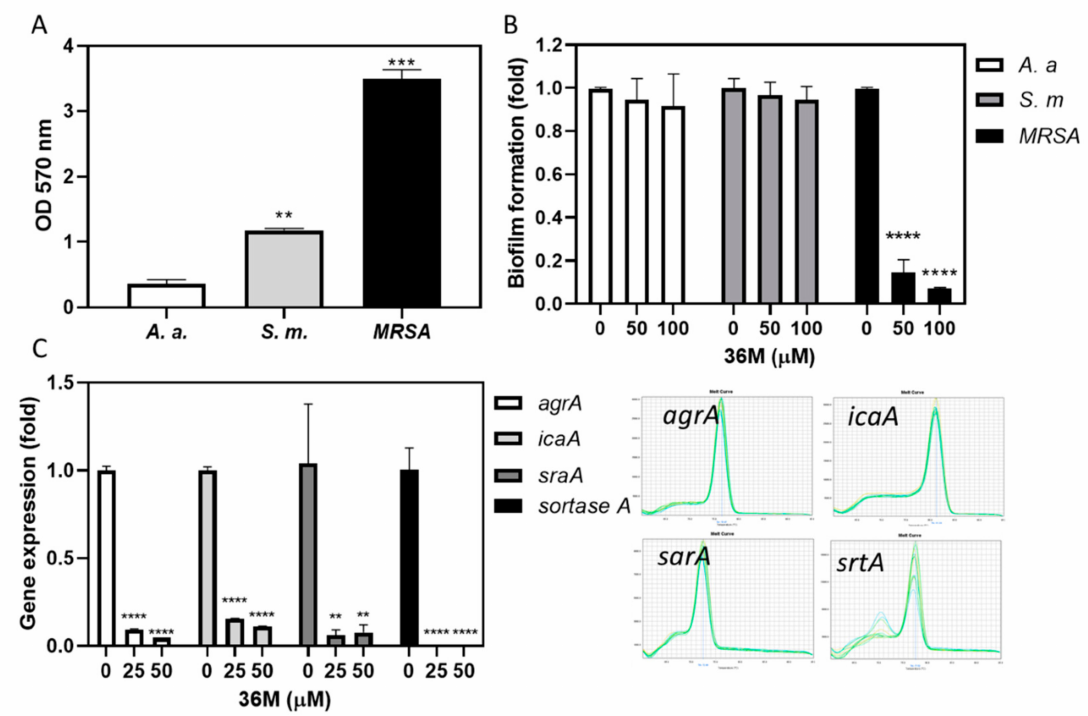
Figure 5. The 36M derivative reduced MRSA biofilm formation. ( A ) Biofilm-forming ability of A. actinomycetemcomitans ( A . a .), S. mutans ( S . m .), and MRSA. ( B ) Biofilm-formation ability of the three microbes after 36M treatments. ( C ) Left: biofilm formation-related gene expression level after 36M treatment for 48-h. Right: melting curves of agrA , icaA , sarA , and srtA amplicons. ** p < 0.01, *** p < 0.001, and **** p <